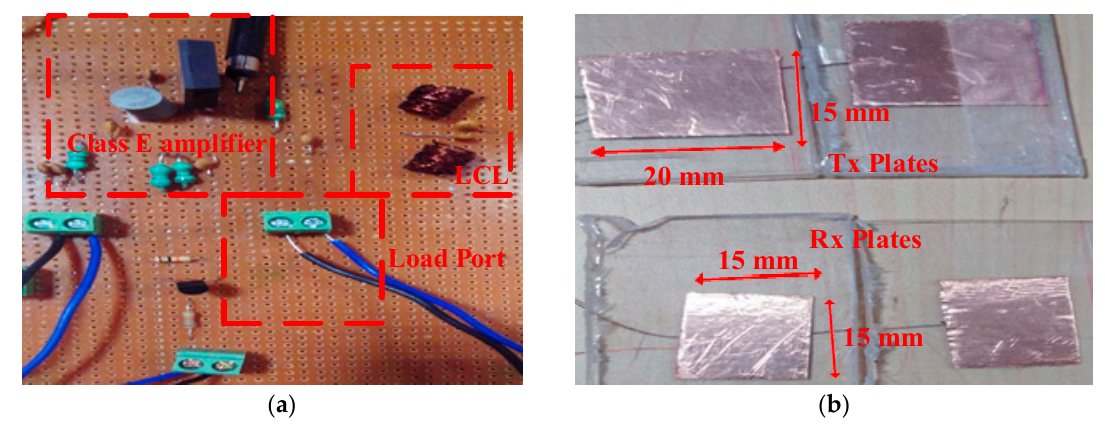
Figure 19. Designed PA circuit ( a ); class E PA board ( b ) Tx and Rx Plates.